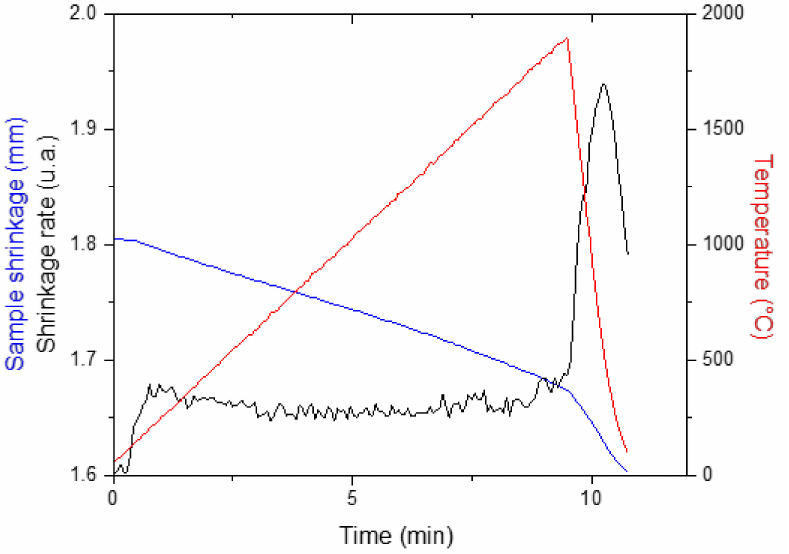
Figure 16. Sintering curve of a diamond nanopowder recorded under 5 GPa upon heating up to 1900 ◦